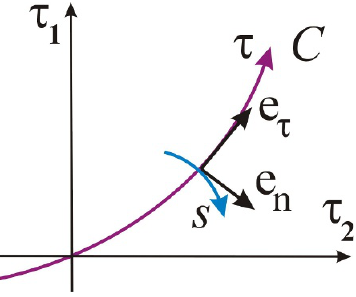
) = f b ( (cid:28) ). The new (local) system of 1 2